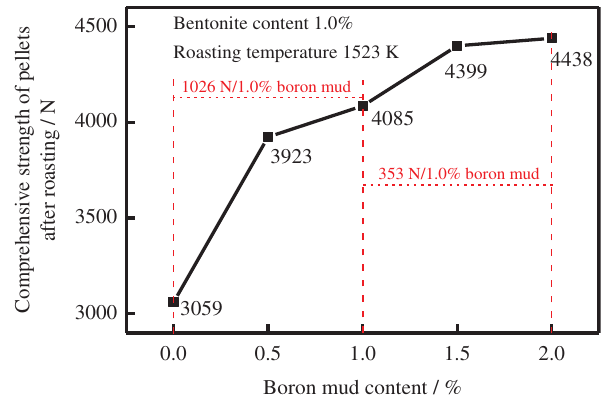
Figure 1: Effects of boron mud on comprehensive strength of pellets after